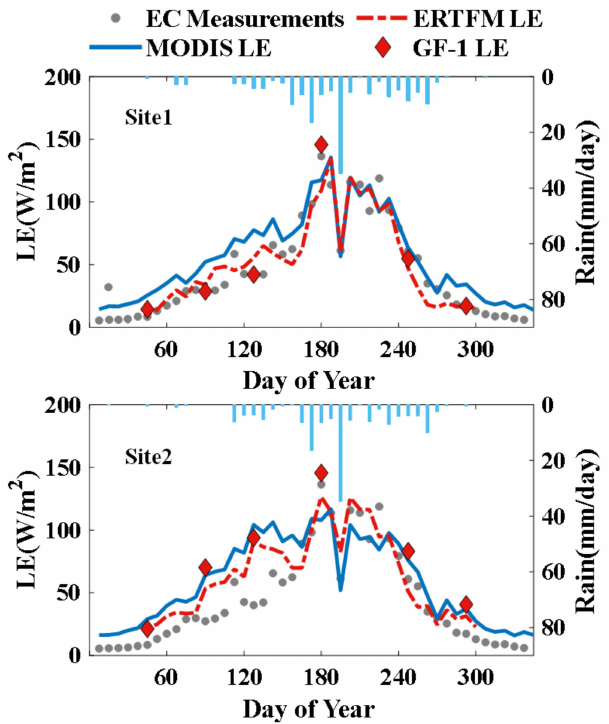
Figure 12. Time series of the MODIS LE (blue line), the GF-1 LE (red diamond), and the ERTFM-based LE (red line) products validated by the EC measurements (gray circles) on an 8-day average scale. Blue bars indicate rainfall